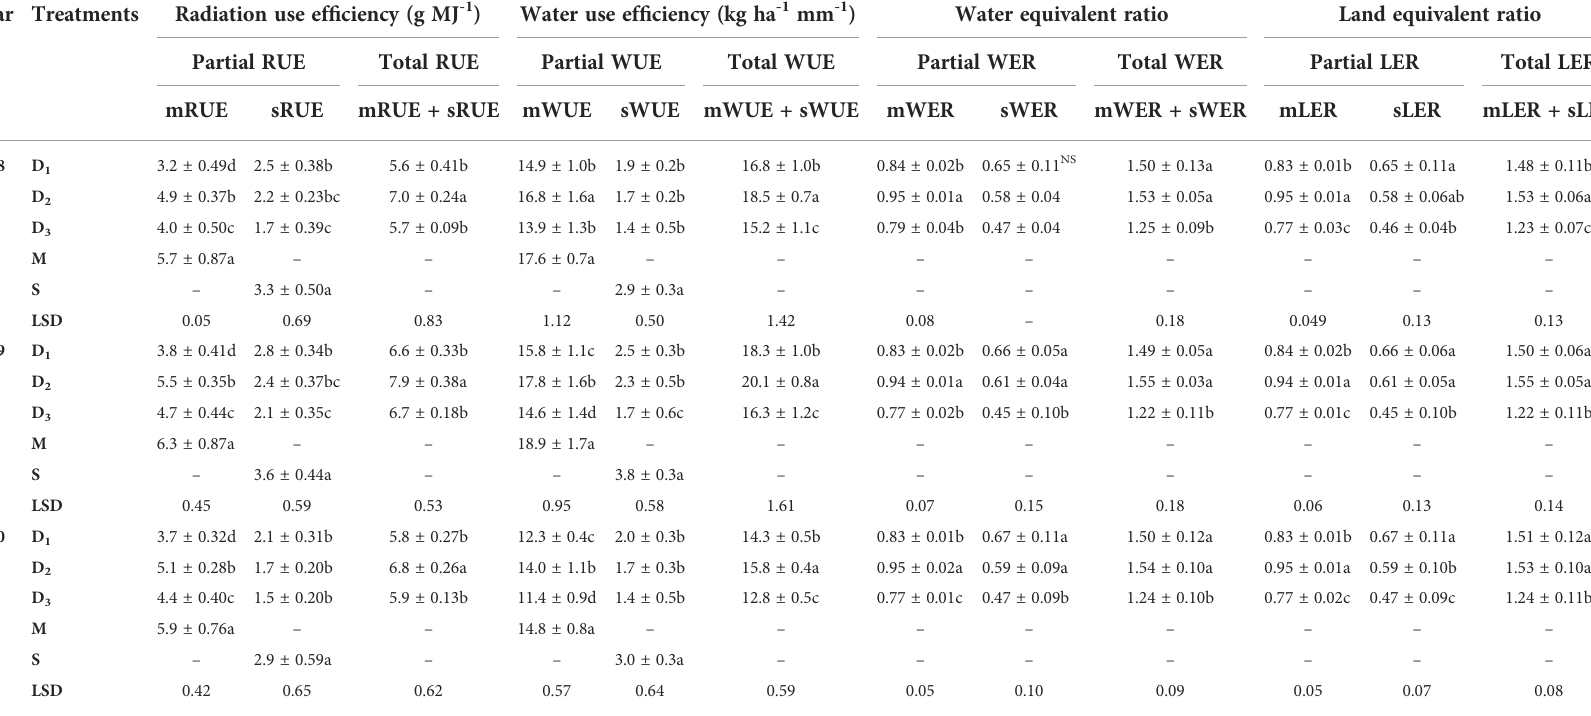
TABLE 6 Radiation-use-ef fi ciency (RUE), water-use-ef fi ciency (WUE), water equivalent ratio (WER), and land equivalent ratio (LER) of maize and soybean under different maize/soybean strip intercropping treatments and sole cropping of maize and